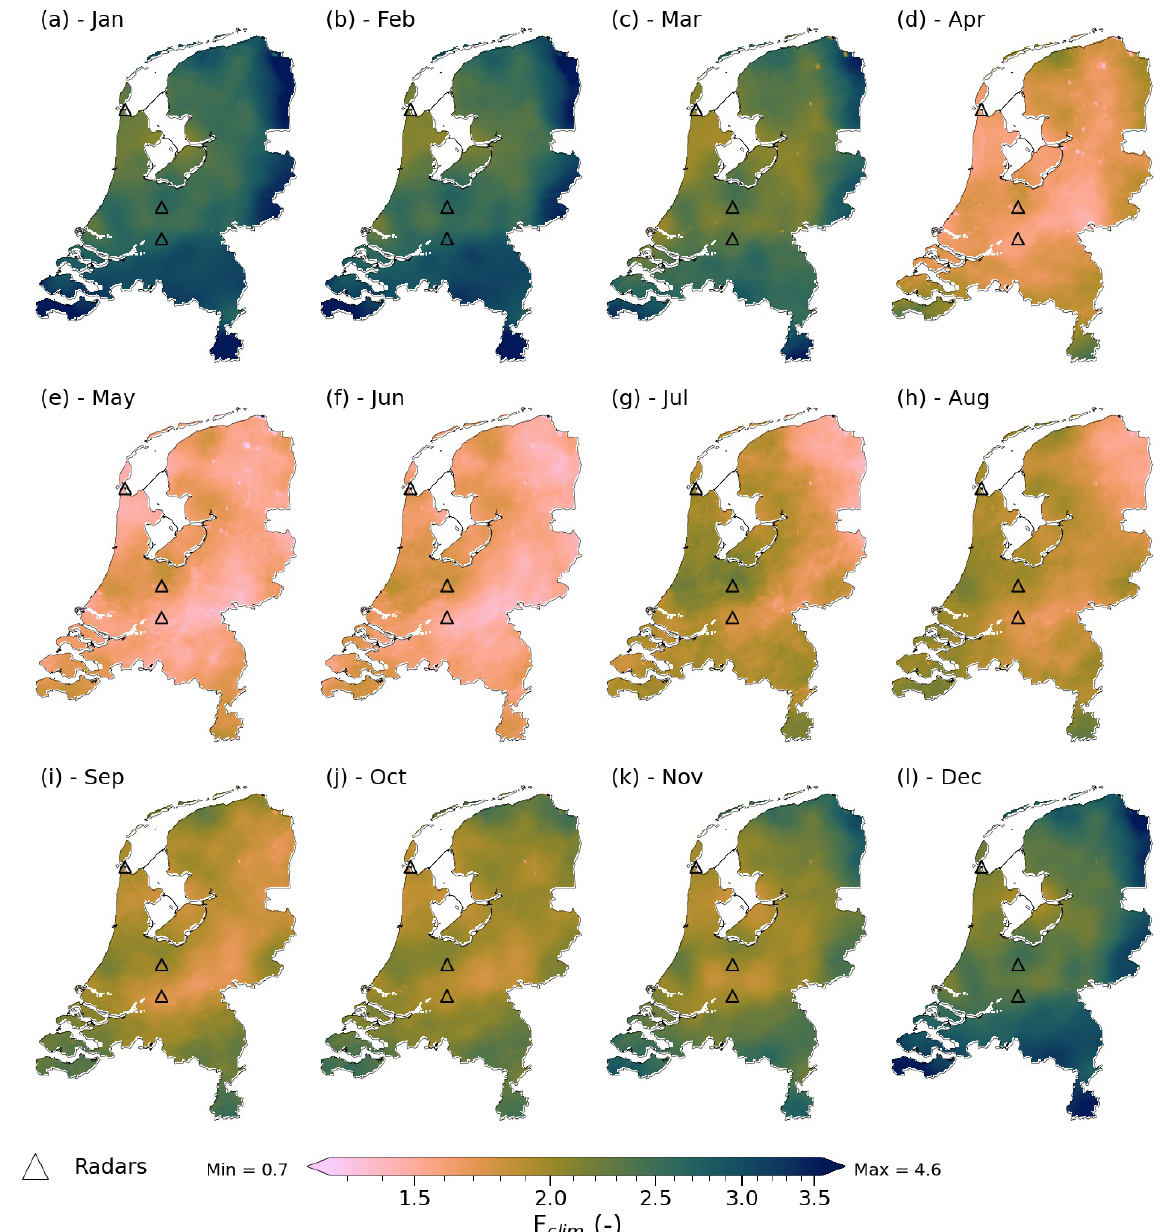
Figure 3. Spatial variability of the CARROTS factors, as derived from the archived radar and reference data for the period 2009–2018. Shown are monthly averages of the daily